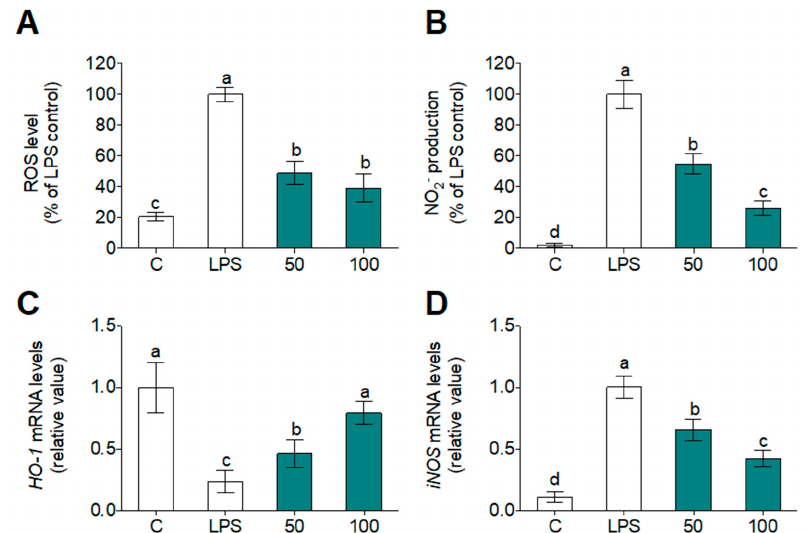
Figure 4. Intracellular ROS ( A ) and nitrite ( B ) production, expressed as a percentage of fluorescence/absorbance, and HO-1 ( C ) and iNOS ( D ) mRNA levels after 24 h incubation with or without LPS (100 ng/mL) and WGPH45A at 50 and 100 μ g/m. Values are presented as means ± SD ( n = 3) and those marked with different letters are significantly different ( p < 0.05).